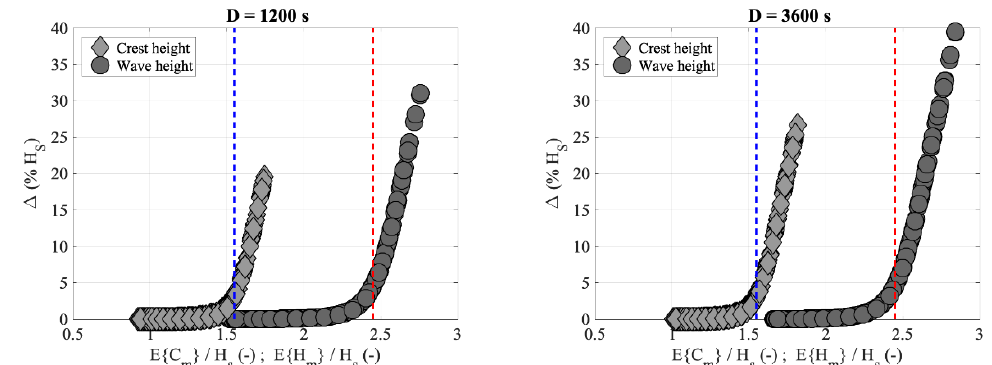
Figure 4. Space-time extreme crest and wave heights. Relative errors ∆ given by (E{ C m } − E{ C m } BC ) / H s and (E{ H m } − E{ H m } BH ) / H s as a function of the normalized expectations E{ C m } / H s and E{ H m } / H s , respectively. The vertical lines show the two ultimate dimensionless heights B C = 1.55 (dashed blue line) and B H = 2.45 (dashed red line). ( left ) Time interval duration D = 1200 s and ( right ) time interval duration D = 3600 s. Sea state parameters: H s between 1.3 and 6.7 m, mean wavelength L x between 24 and 85 m, zero-crossing mean period T z between 4.4 and 7.9 s, and mean steepness µ between 0.035 and 0.074.